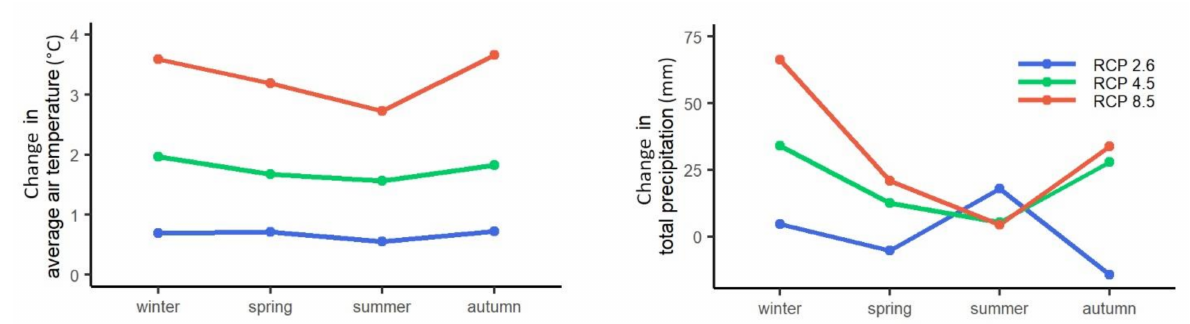
Figure 1. Climate change signal of the average air temperature and total precipitation per season between the historical period 1976–2005 and the projections